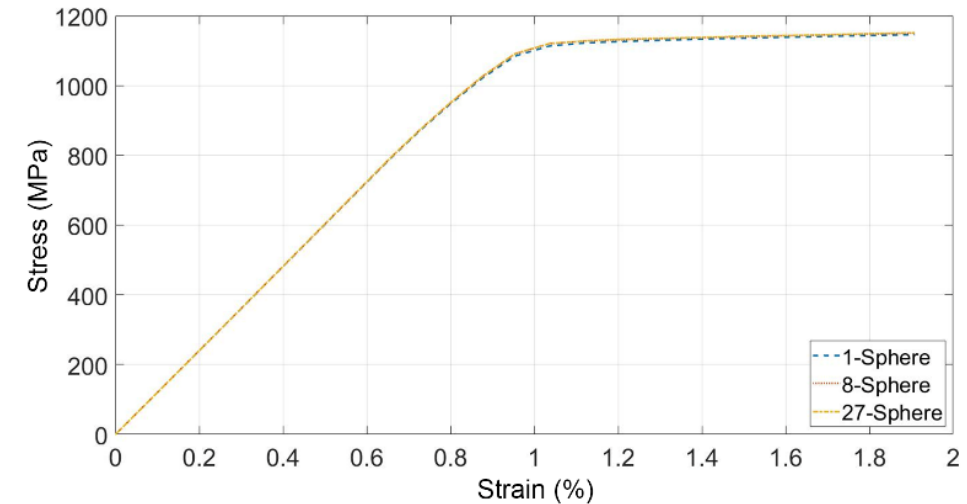
Figure 6. Stress-strain curve for different meso-scale model arrangements.